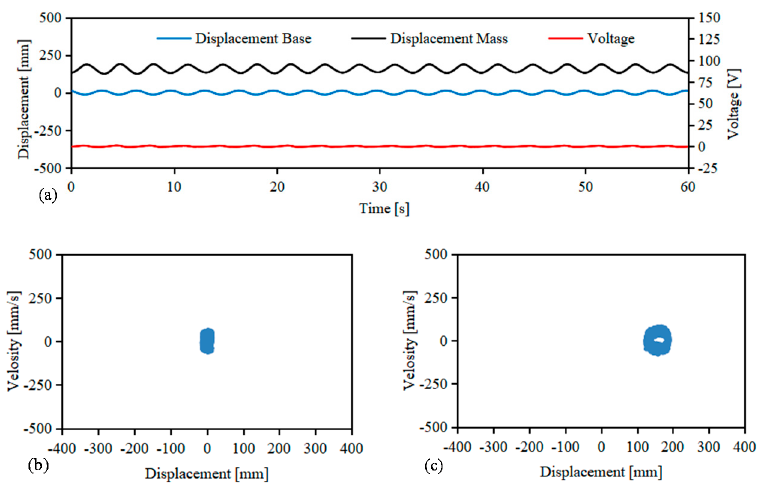
Figure 8. Measurement results of response vibration displacement and vibration power generation when vibrating with a period signal 0.3 Hz. ( a ) Results of response vibration displacement. ( b ) Diagram of displacement velocity of vibration of the support. ( c ) Diagram of displacement velocity of vibration of the mass block.